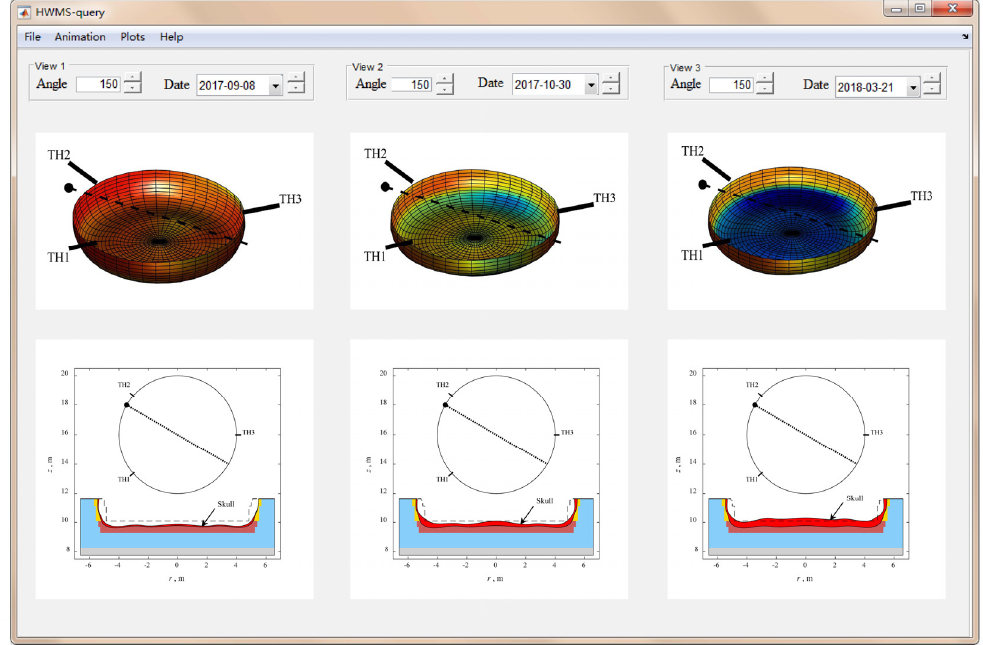
Figure 4. Three-dimensional representations of the internal geometry of the blast furnace hearth for three selected dates.